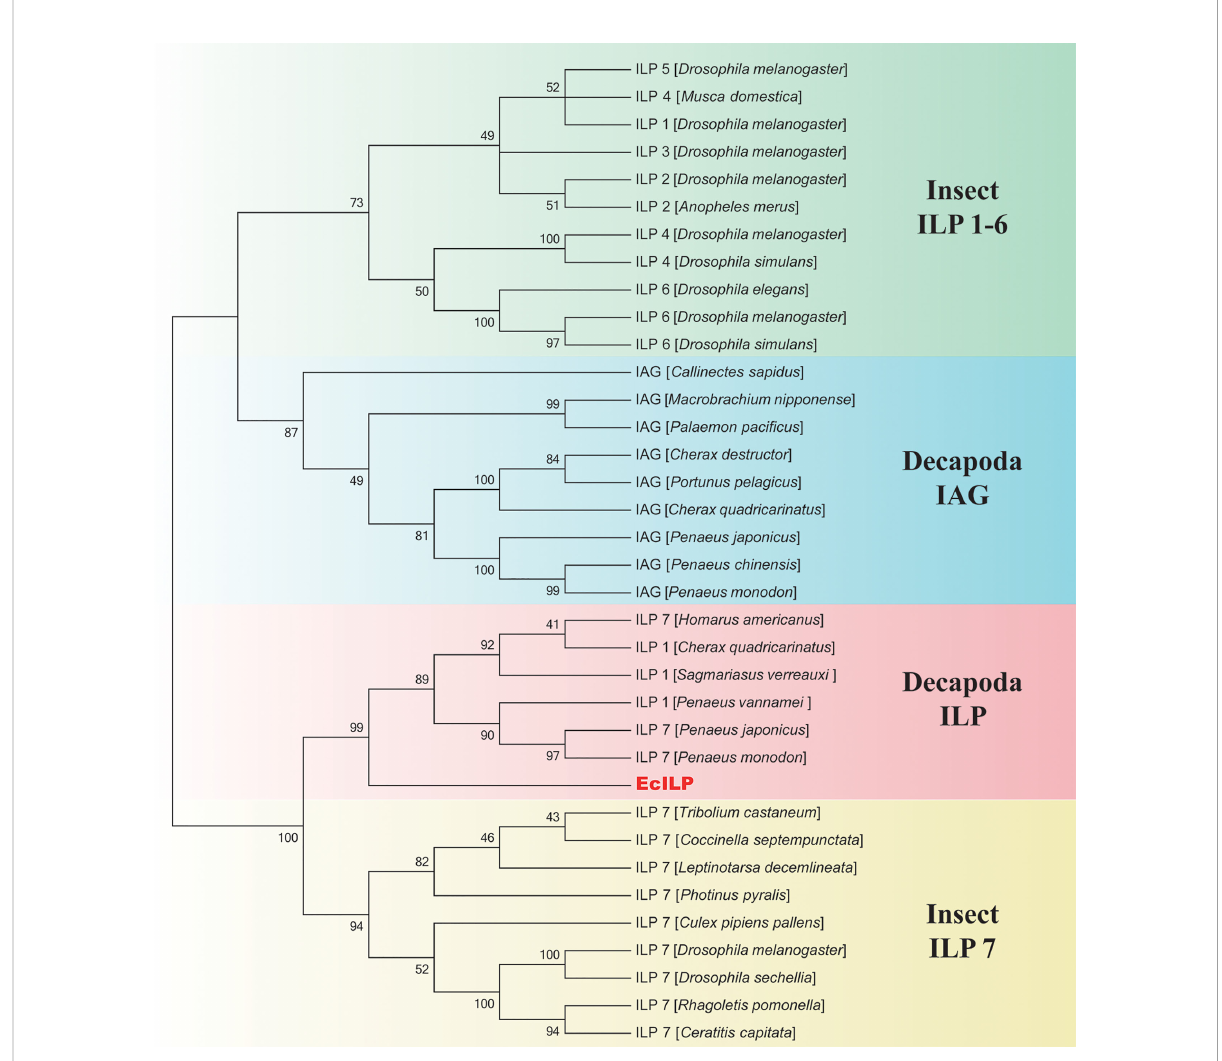
FIGURE 3 Phylogenetic relationships of insulin-like superfamily members in arthropod. The numbers on the forks are the bootstrap proportions for each branch. The phylogenetic tree was constructed using neighbor-joining (NJ) approach with 1,000 bootstrap replicates.